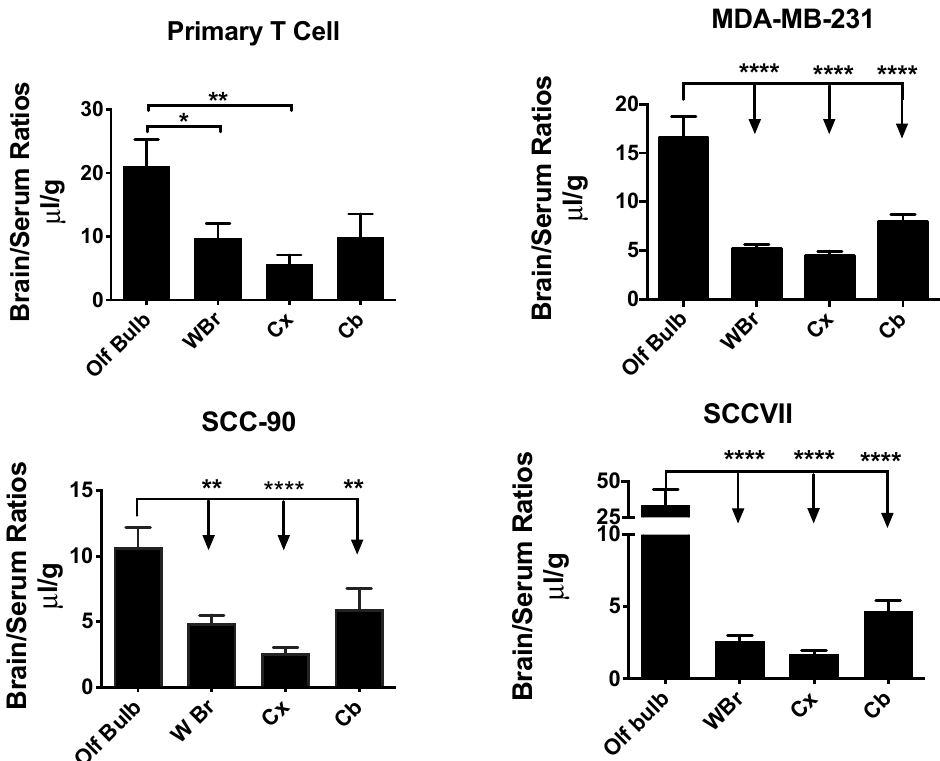
Figure 5. Variation in the uptake of different exosome populations by brain regions. Four exosome populations showed a significantly greater uptake by the olfactory bulb (OB) than by whole brain (WBr), cortex (Cx), or cerebellum (Cb). * p < 0.05, ** p < 0.01, **** p < 0.0001.